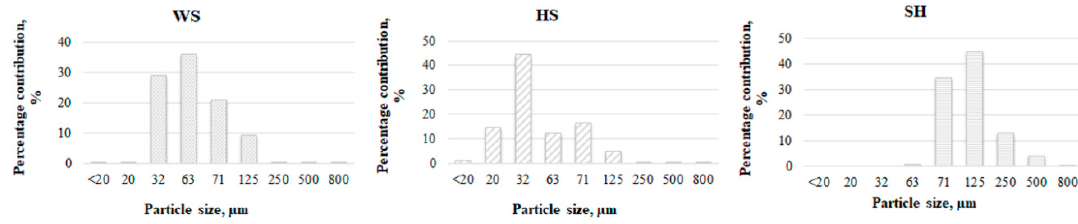
Figure 2. Particle size distribution by weight of ground ground walnut (WS), hazelnut shell (HS), and sunflower husk (SH).